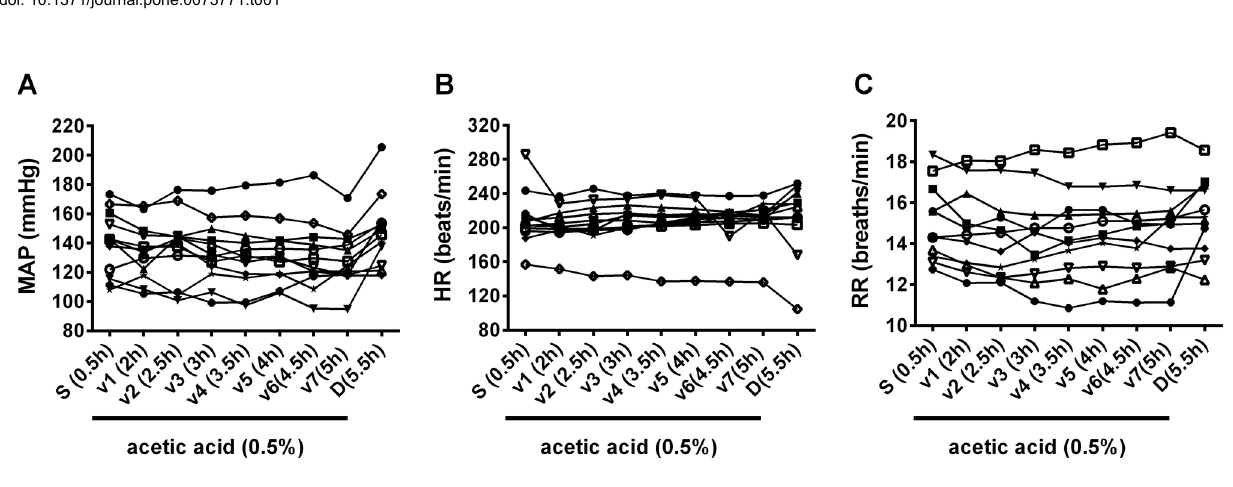
Figure 5. Time course of cardiovascular and respiratory parameters. Raw values from individual cats (each line represents data from an animal) are shown for: . A. Mean arterial pressure (MAP). Data included are from 12